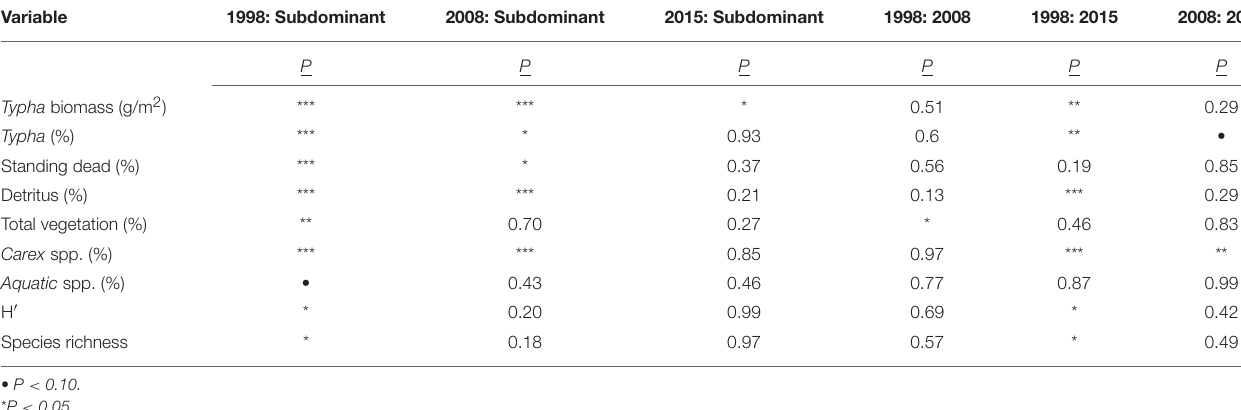
TABLE 3 | Pairwise comparison of variable values by age classes determined by LME model (with Typha stand as a source of random effects) and Tukey post-hoc tests. Variable